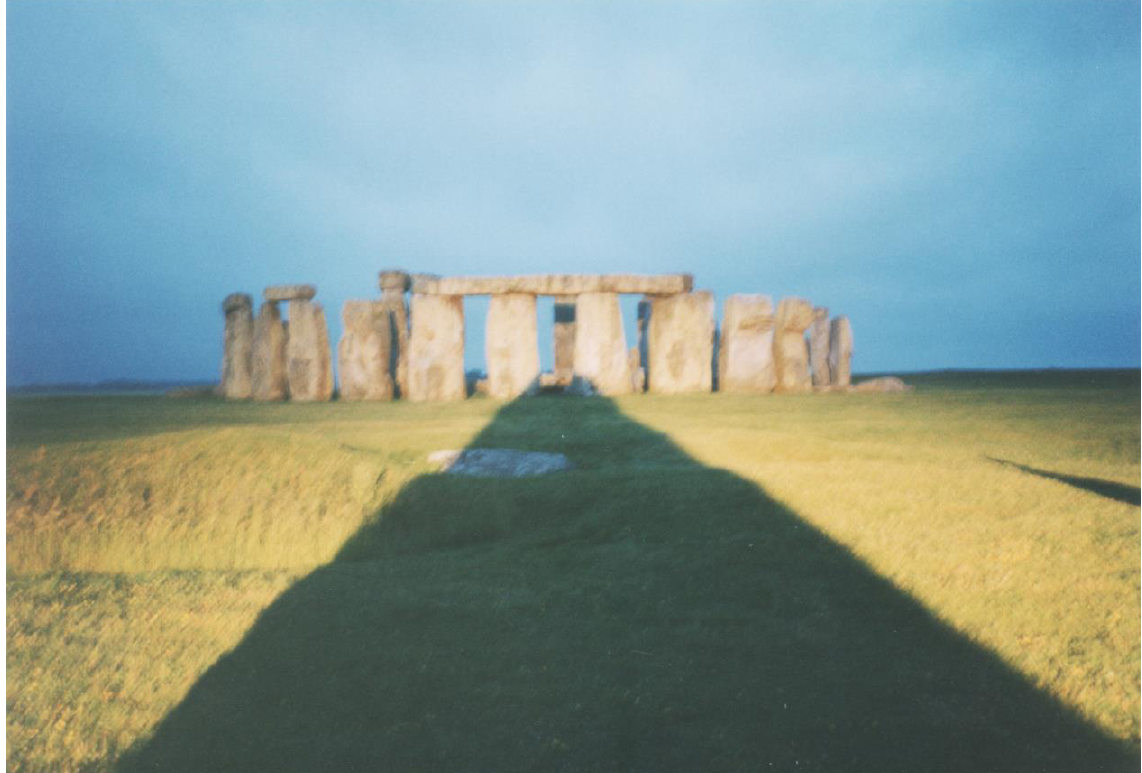
Figure 5. The ingenuity of the ancients: In midsummer week the sunrise shadow of the phallic-shaped Heel Stone enters the Stonehenge monument and reaches the focal stone called the Altar Stone. This is a reconstruction photographed by the author sitting with his back against the Heel